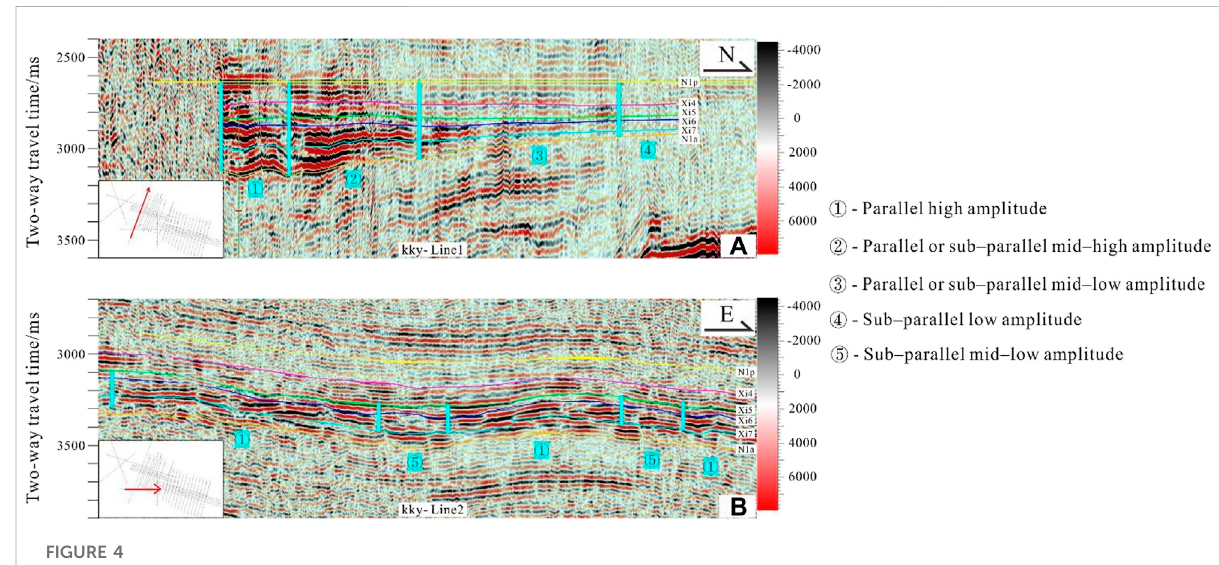
FIGURE 4 Seismic pro fi le of the kky-line1 and kky-line2 in the Kekeya survey